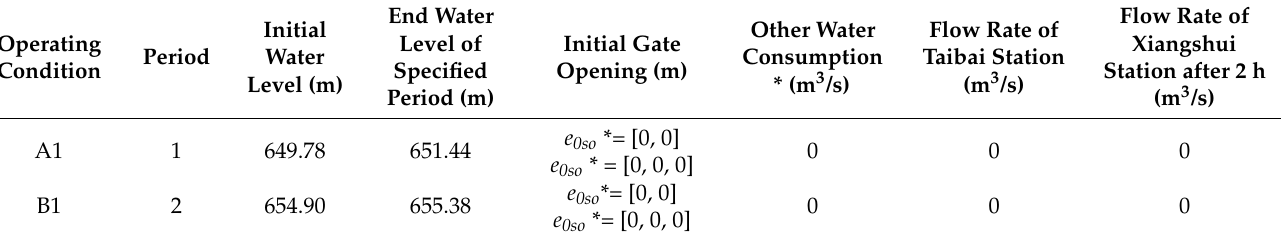
Table 6. Simulated conditions of plug-in model of reservoir outflow discharge calculation.